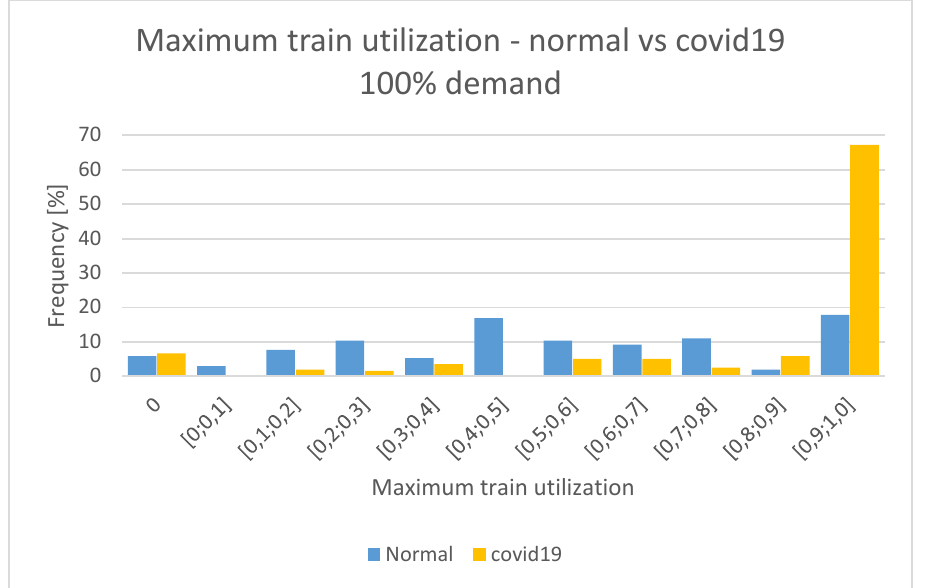
Figure 9. Maximum train utilization in normal and covid19 for 100%